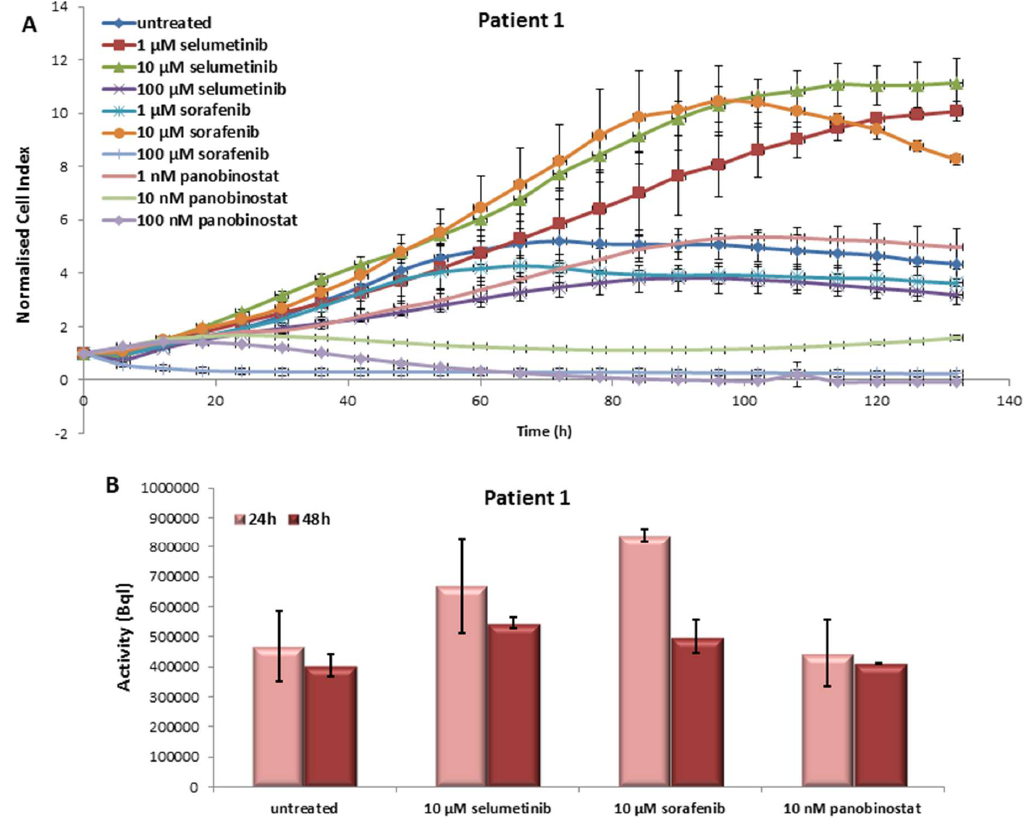
Figure 1. Effects of selumetinib, sorafenib and panobinostat on cell viability and RAI-U